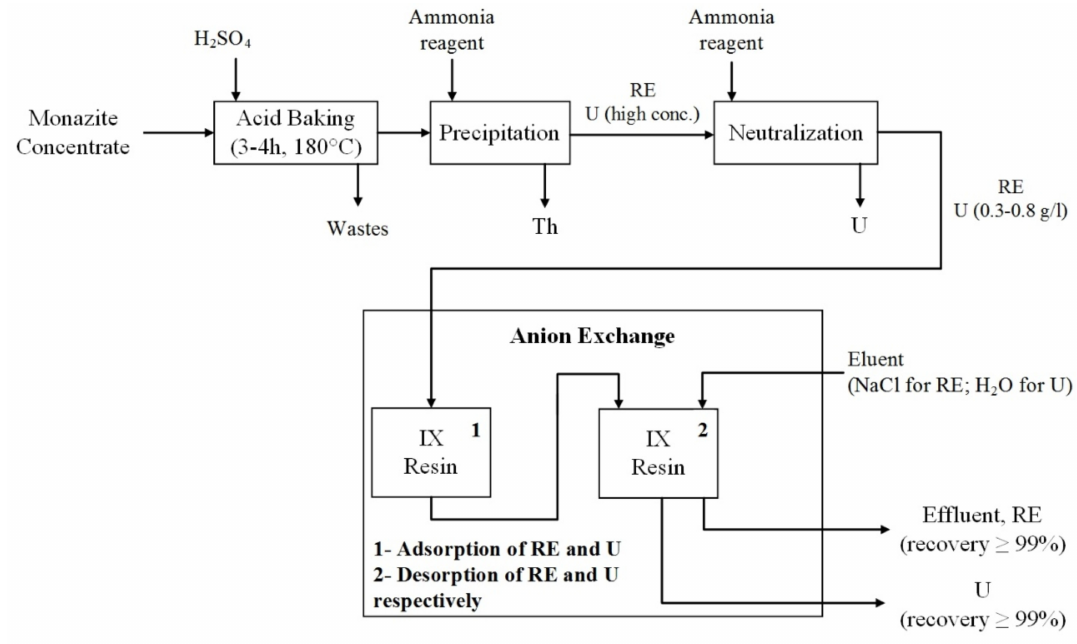
Figure 8. Flow diagram of uranium removal from